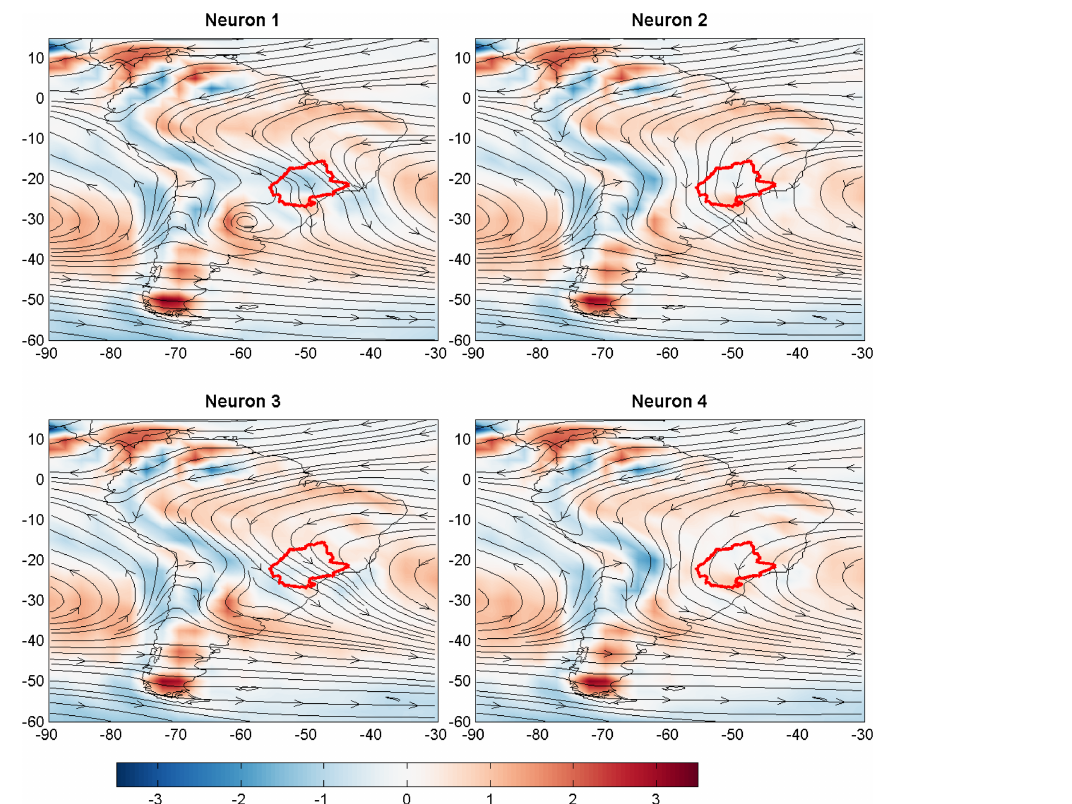
Figure 5. Streamlines for the vertically integrated moisture fluxes and low-level (850mbar) relative vorticity (10 − 5 s − 1 ) averaged over each neuron class. The red contour line shows the Upper Paraná River